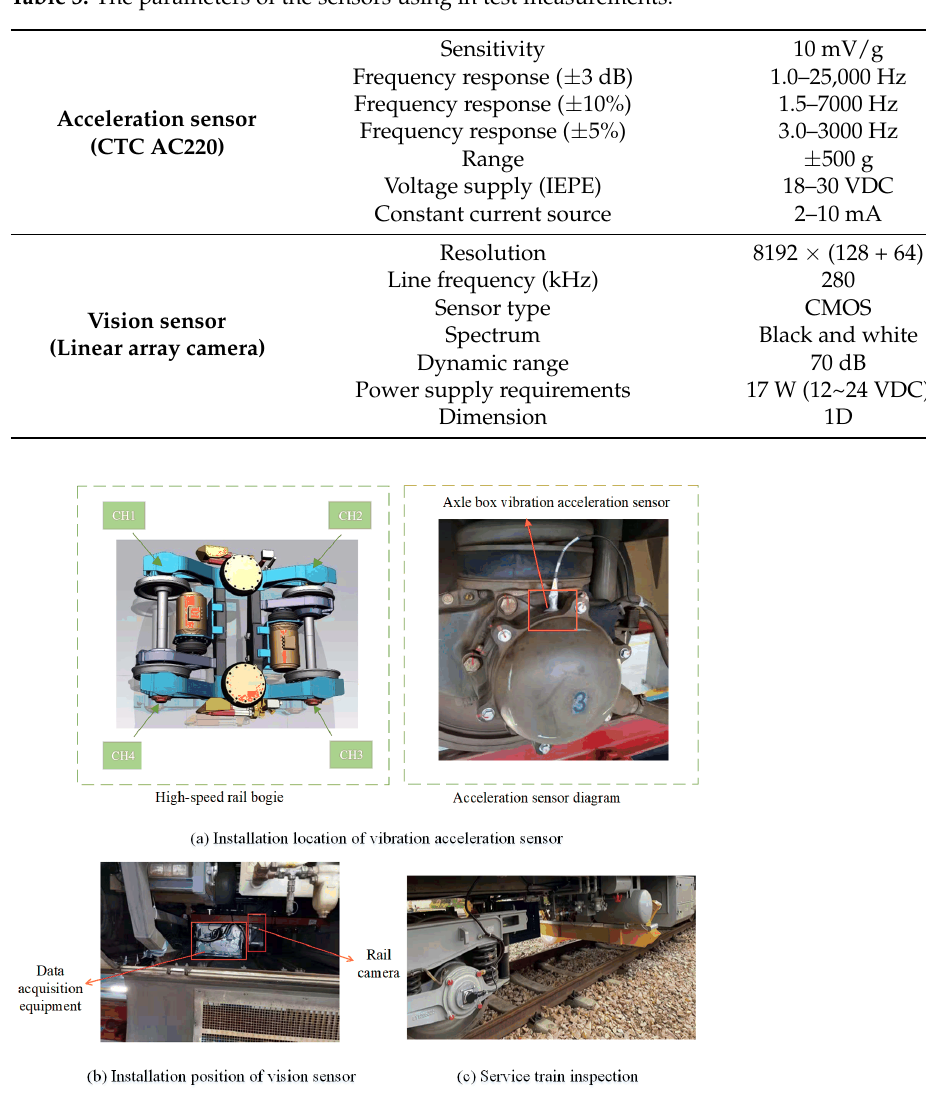
Table 3. The parameters of the sensors using in test measurements.